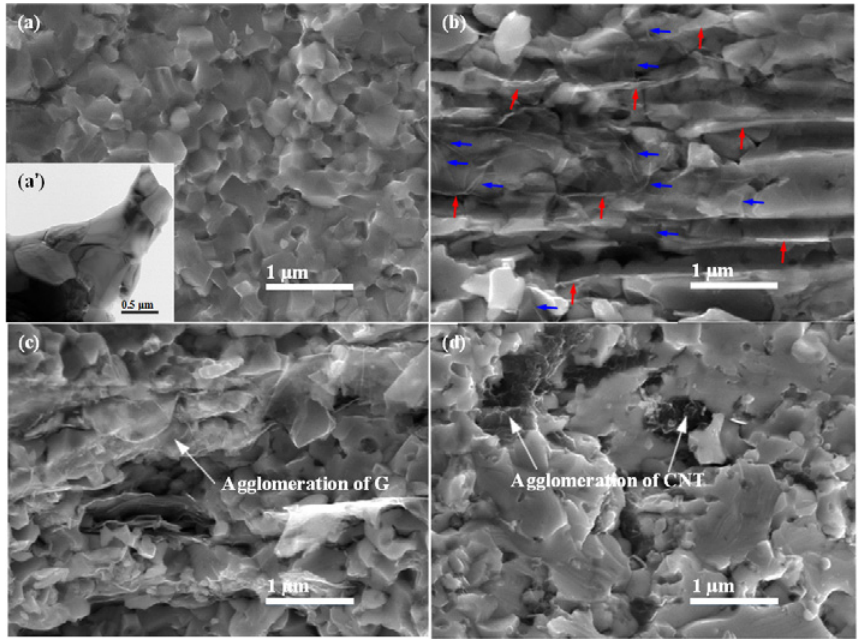
Fig. 3 (a, b, c, and d) Fracture surfaces of HEC 0-0 , HEC 1-2 , HEC 1-0 , and HEC 0-1 , respectively and (a') TEM image showing grain size of HEC (the red and blue arrows indicate G and CNT,